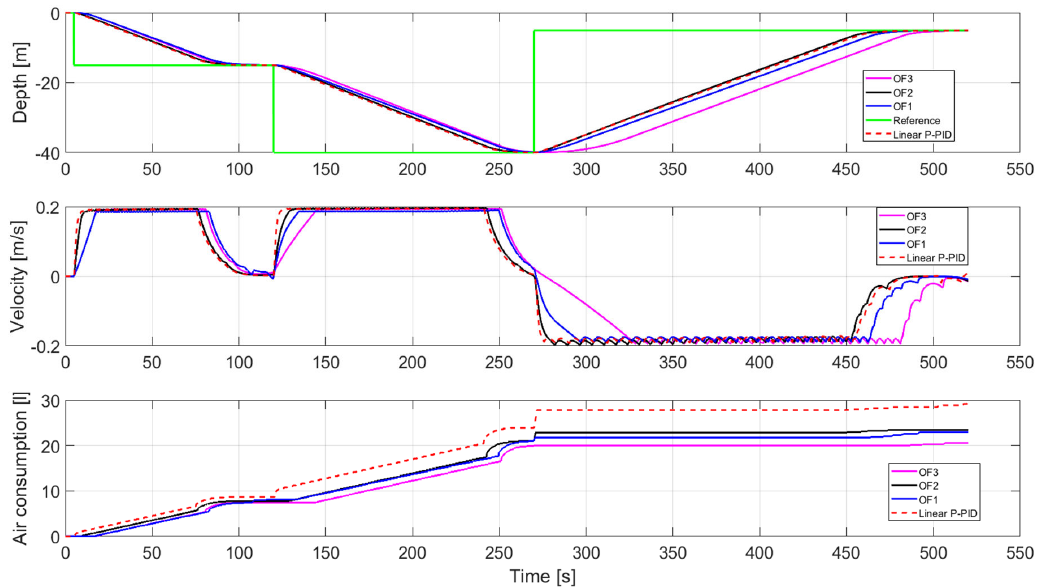
Figure 10. Velocity FLCS response obtained with all three objective functions compared to the cascaded linear P-PID controller.